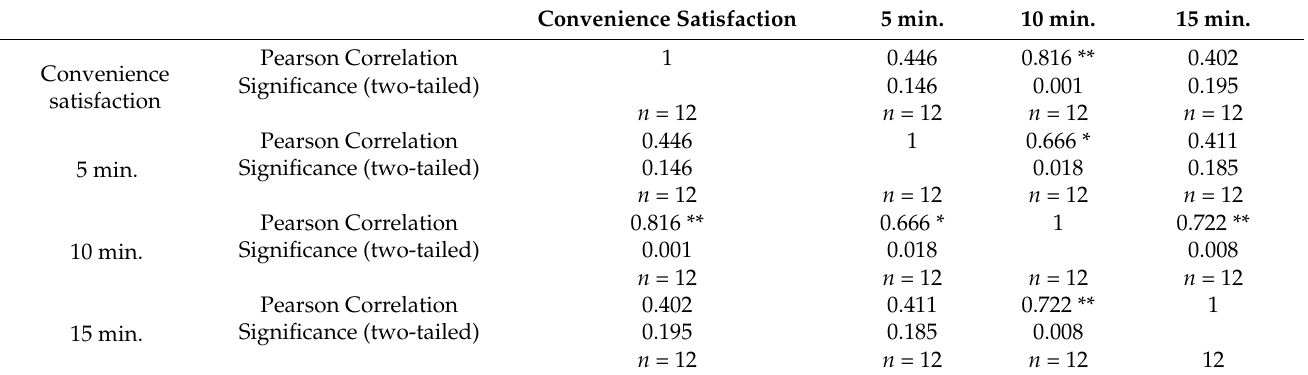
Table 4. Correlation between convenience satisfaction and 5-, 10-, and 15-minute walking-accessible